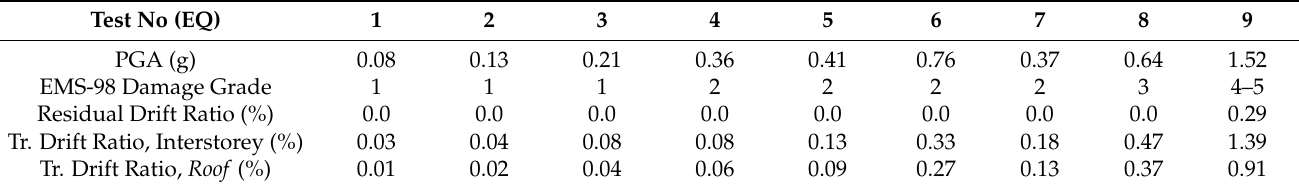
Figure 7. Shake table test input − motion sequence. Table 1. Summary of the intensity measure amplitudes and damage observed in each shake-table test.